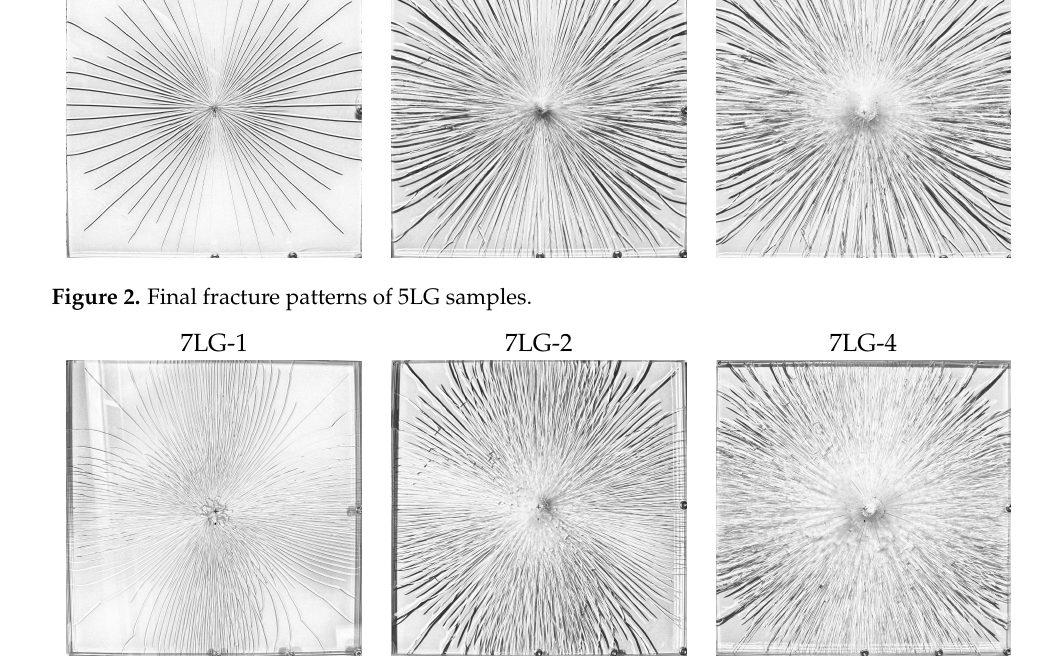
Figure 3. Final fracture patterns of 7LG